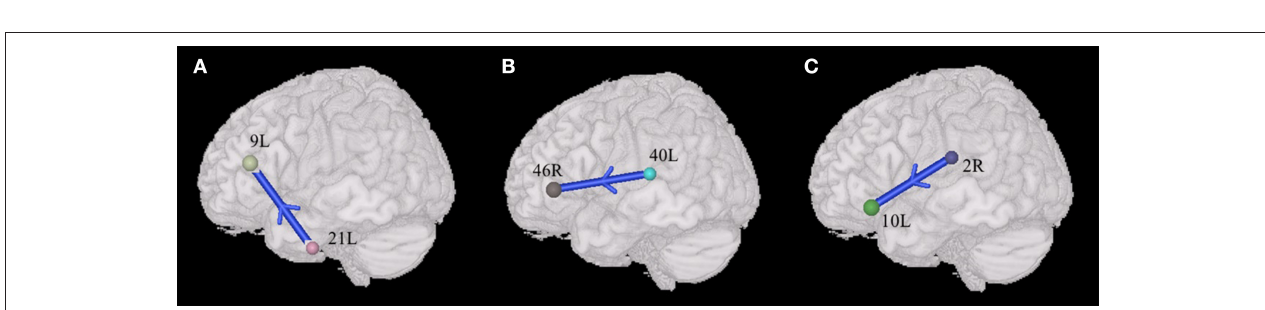
FIGURE 2 | Alterations of the entropy connectivity from the prefrontal cortex to posterior brain regions ( p < 0.05, two-sided, PRT corrected; reproducible rate: 0.85; number of subjects: 70; PRT threshold: 1,000). (A) Synchronous entropy connectivity. (B–D) Asynchronous entropy connectivity. The blue arrows denote weakened interregional connections. Every colored sphere in the figure indicates the seed brain region of entropy connectivity, and the color of the sphere is randomly generated and has no special meaning. The number next to the sphere is the index of BA (see Table 2 for details). The direction of the arrow indicates the direction of directional connectivity.